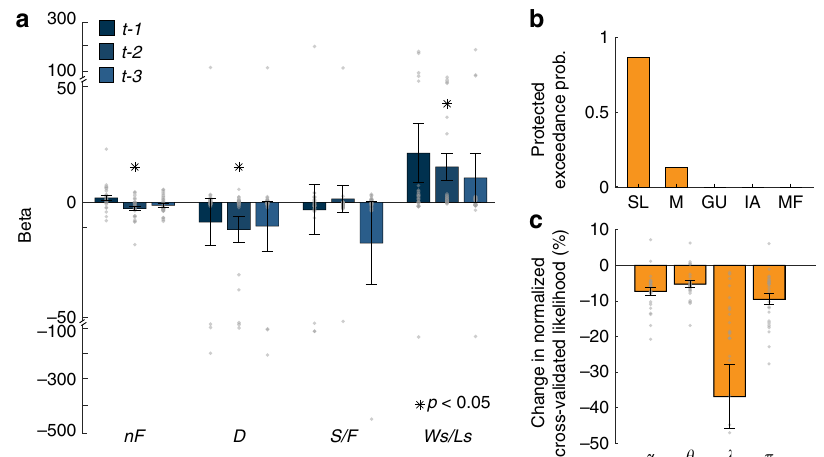
Fig. 2 Model validation and comparison. a Model-free analysis. We regressed the behavioral decision on the number of free-riders ( nF ), decision ( D ), success or failure to generate the public goods ( S / F ), and win-stay and lose-switch strategy ( Ws/Ls ) in previous trials up to three trials back. * p < 0.05 (mixed-effect logistic regression). b Model comparisons based on the Bayesian model selection. The protected exceedance probabilities indicate that the social learning (SL) model explains decisions in PGG better than other alternative models: myopic (M); group utility (GU); inequity aversion (IA); model- free analysis (MF). c Changes in quality of fi t resulting from removing free parameters in the social learning model; ⍺ , learning rate; θ , weight on learning rate; λ , contribution cost; π , willingness to make altruistic decisions.